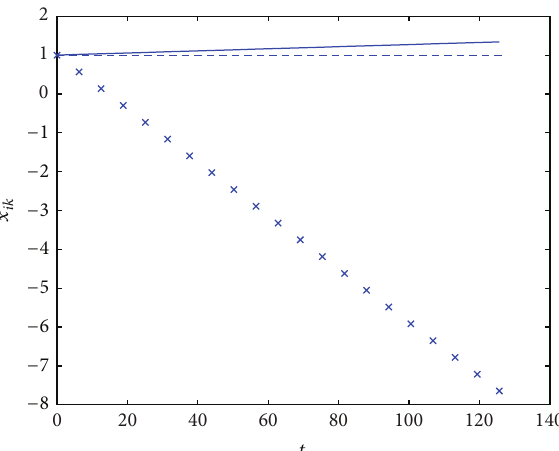
Figure 1: Numerical results for (12) with 𝑐 1 = 1/2 . 𝑘 = 4 ( × × ), and 𝑘 = 5 (—), 𝑘 = 10 (––